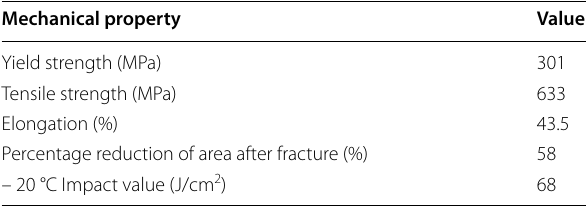
Table 4 Mechanical properties of the CuMn by wire arc additive manufacturing